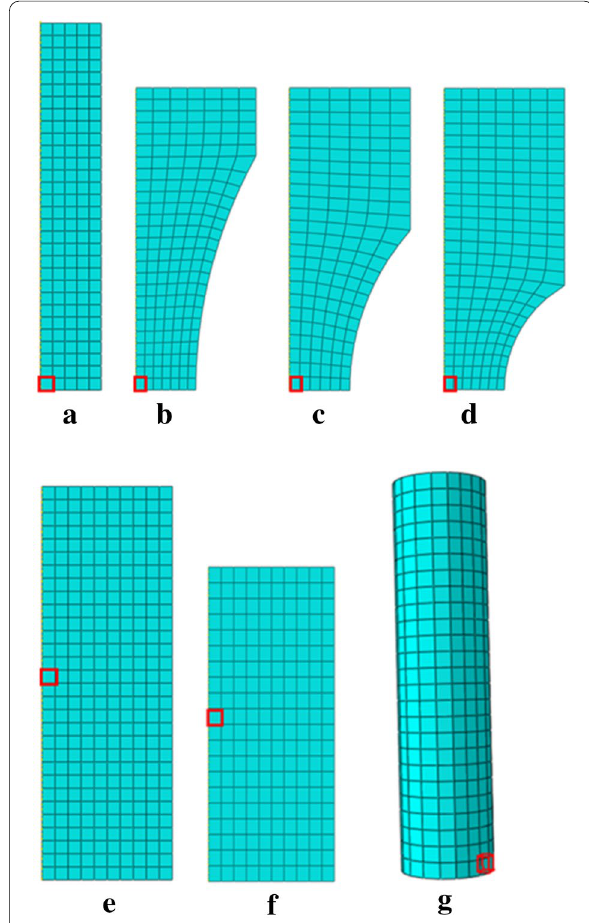
Figure 9 The finite element mesh with critical elements: a SRB, b NR20, c NR10, d NR5, e cylinder with a height-to-diameter ratio of 1.5, f cylinder with a height-to-diameter ratio of 1.0, and g torsion test